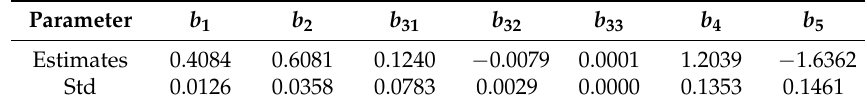
Table 7. Estimates for the parameters and variance-covariance structure for the quantile regression for linear mixed-effects outer crown profile